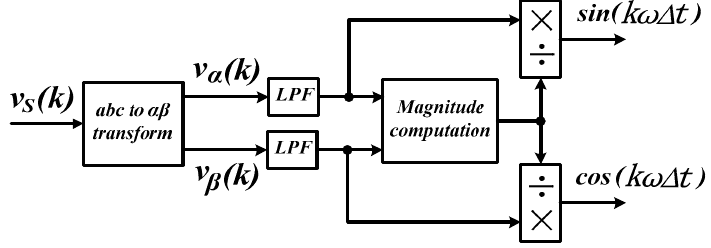
Figure 10. Control structure of unit vector synchronization technique [61–63].